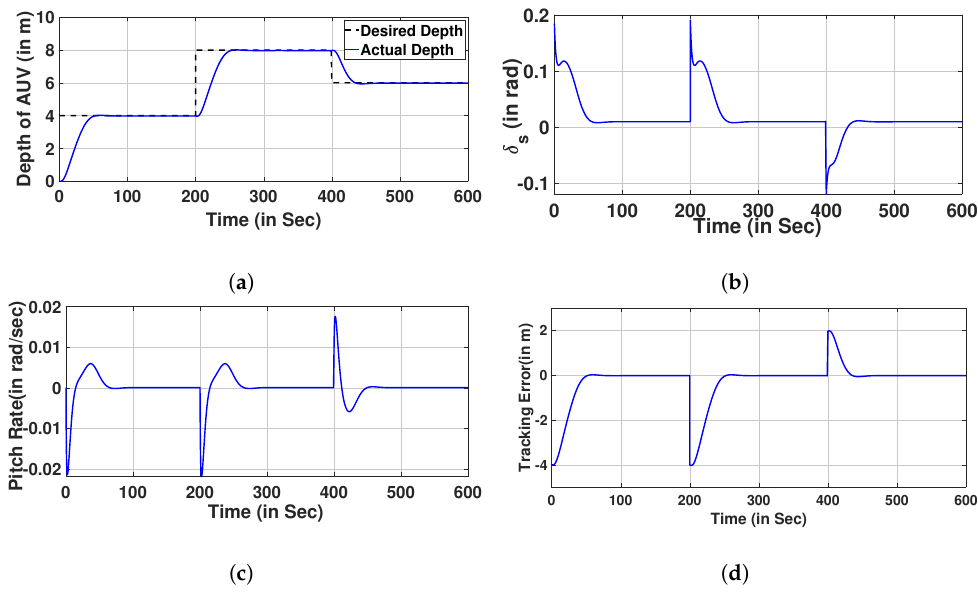
Figure 5. Control of depth for ± 10% uncertainty. ( a ) Tracking of Desired Depth, ( b ) Control Input, ( c ) Pitch Rate, ( d ) Error Signal.